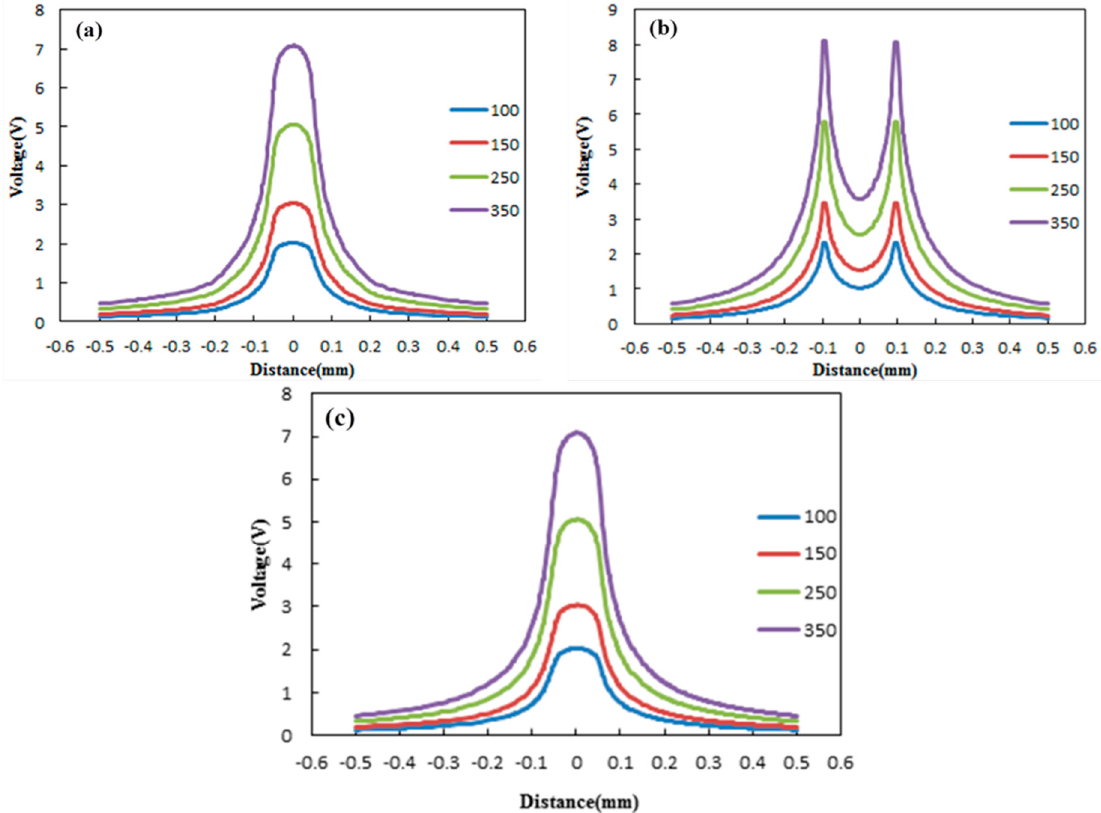
Figure 8. One-dimensional distributions of the extracellular potential (V) in three directions of X -axis ( a ); Y -axis ( b ) and Z -axis ( c ) generated by monopole stimulation in STN at various stimulus intensities (100, 150, 250 and 350 μ A).